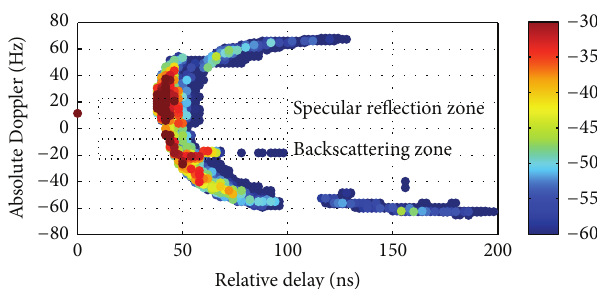
Figure 3: Wide-band delay/Doppler channel IR when passing in a simple urban canyon using asymptotic GO/PO